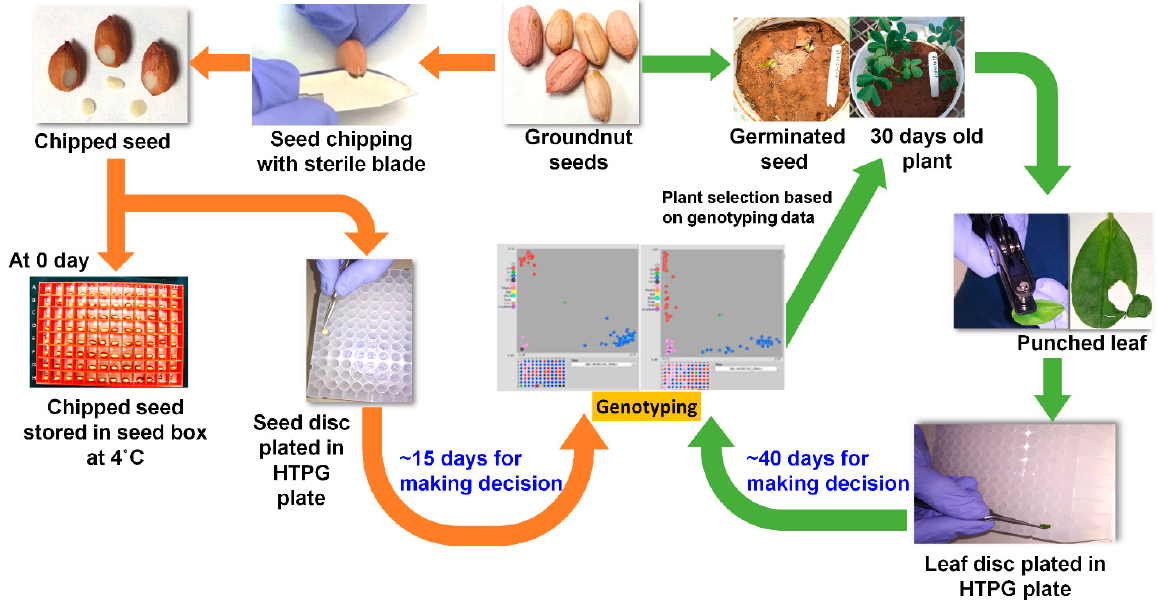
Figure 1. Flowchart showing comparison of seed-based genotyping and leaf-based genotyping.